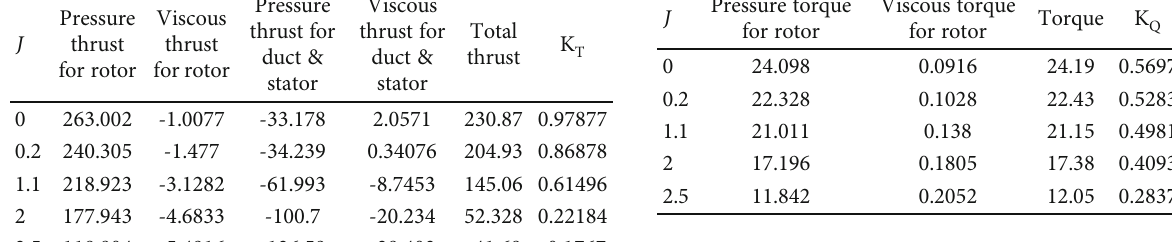
Table 9: Thrust force calculated for the linear jet system without a stator. J